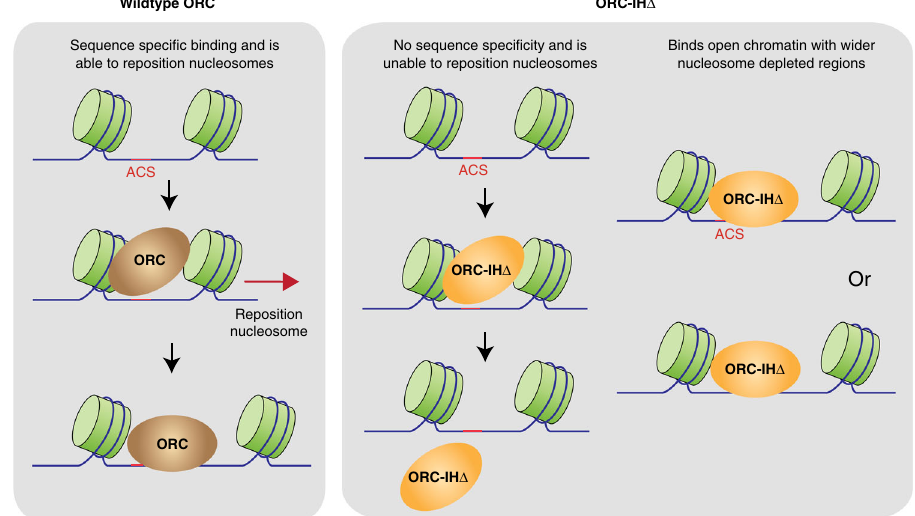
Fig. 7 Model for the selection of binding sites by the WT and mutant ORC. WT ORC binds ACS and is able to reposition the fl anking nucleosomes upon binding 13 . ORC-IH Δ binds promiscuously to T-rich sequences, including ACSs but unable to reposition nucleosomes. Therefore, it binds wider nucleosome- depleted regions that do not require the repositioning of